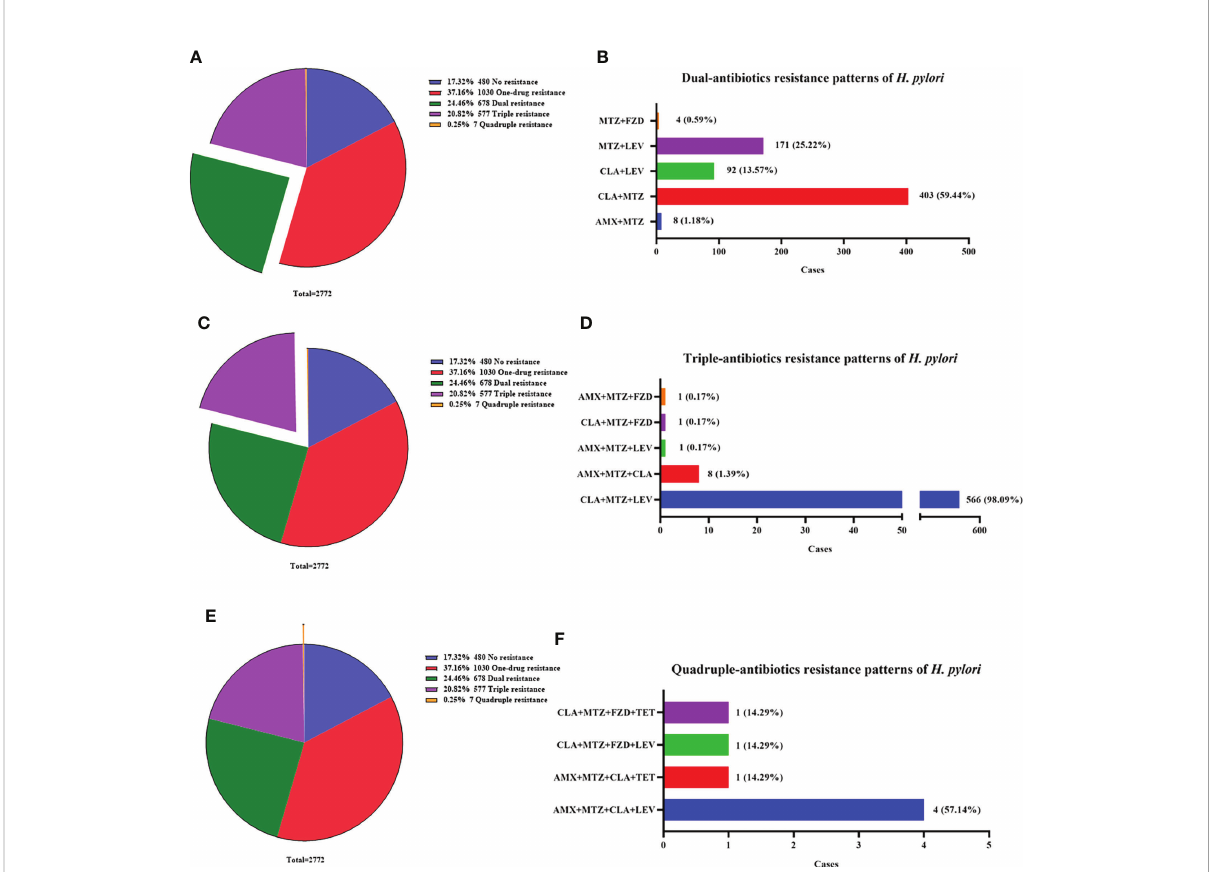
FIGURE 2 Multi-antibiotics resistance patterns of H pylori . (A, B) Dual-antibiotics resistance patterns. (A) Composition of antibiotics resistance patterns. The green part represented the proportion of total dual-antibiotics resistance patterns, accounting for 24.46% (678/2772). (B) Composition of dual- antibiotics resistance patterns. (C, D) Triple-antibiotics resistance patterns. (C) Composition of antibiotics resistance patterns. The purple part represented the proportion of total triple-antibiotics resistance patterns, accounting for 20.82% (577/2772). (D) Composition of triple-antibiotics resistance patterns. (E, F) Quadruple-antibiotics resistance patterns. (E) Composition of antibiotics resistance patterns. The orange part represented the proportion of total quadruple-antibiotics resistance patterns, accounting for 0.25% (7/2772). (F) Composition of quadruple-antibiotics resistance patterns. AMX, amoxicillin; CLA, clarithromycin; FZD, furazolidone; MTZ, metronidazole; LEV, levo fl oxacin; TET, tetracycline.